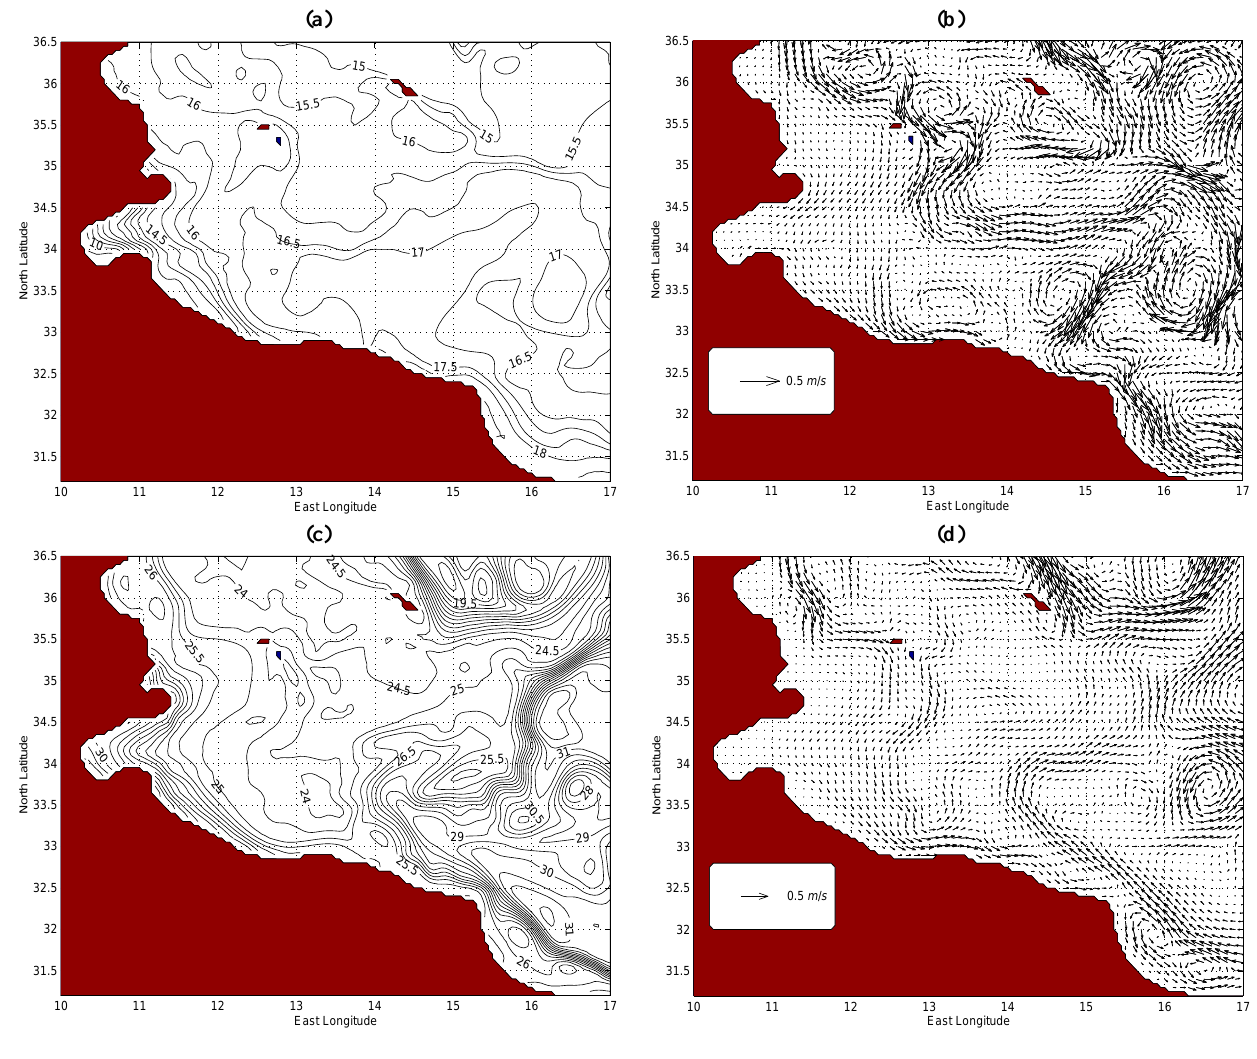
Fig. 17. Ten-day averaged temperature (a) and (c) and total velocity (b) and (d) horizontal fields at 5m depth in February (a) and (b) and August (c) and (d). The temperature contour intervall is 0.5 ◦ C. One vector every two grid points is plotted for velocity. Units are